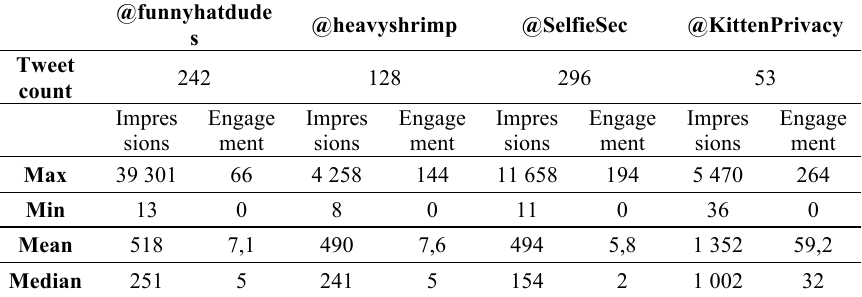
Table 3. The number of tweets and the impressions and engagement statistics for the four case